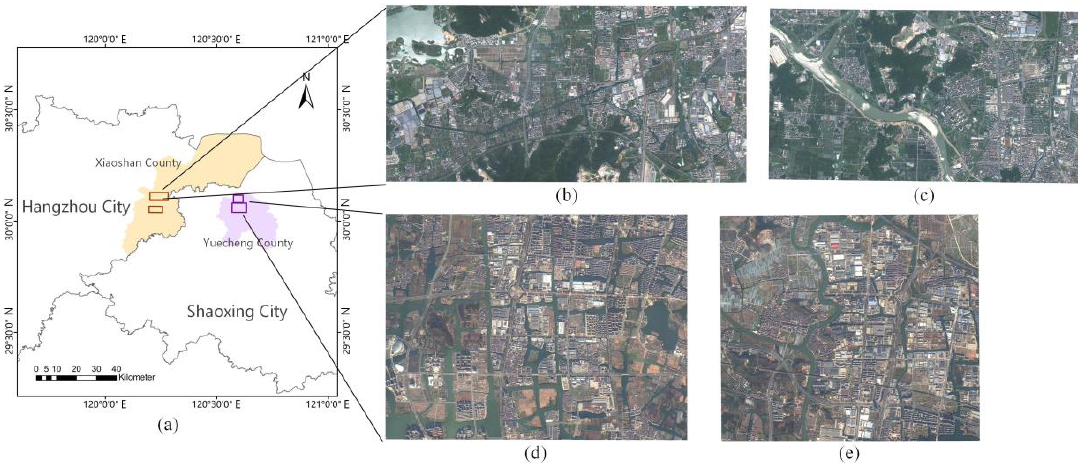
Figure 5. Study areas ( a ) and GaoFen-2 images of Beilun urban scenes ( c ) and Cixi rural scenes ( b ) in true color.